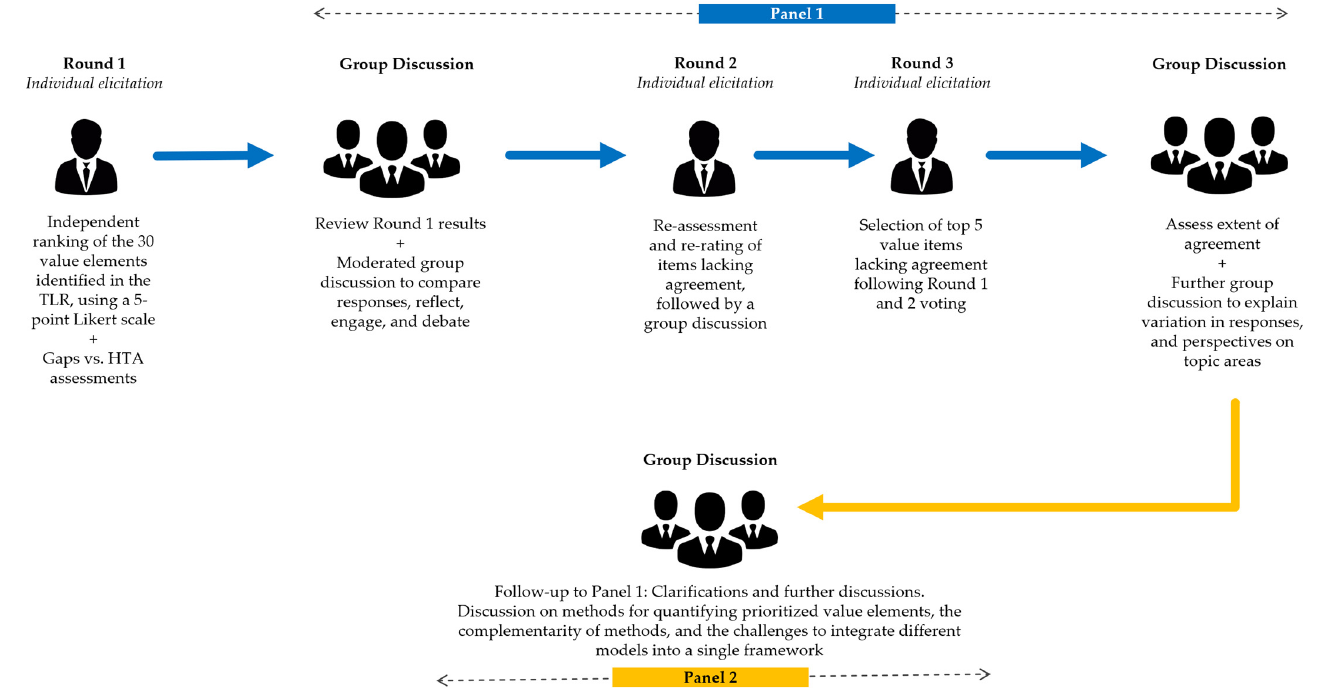
Figure 1. Expert elicitation using a modified Delphi method. HTA, health technology assessment; TLR, targeted literature review.